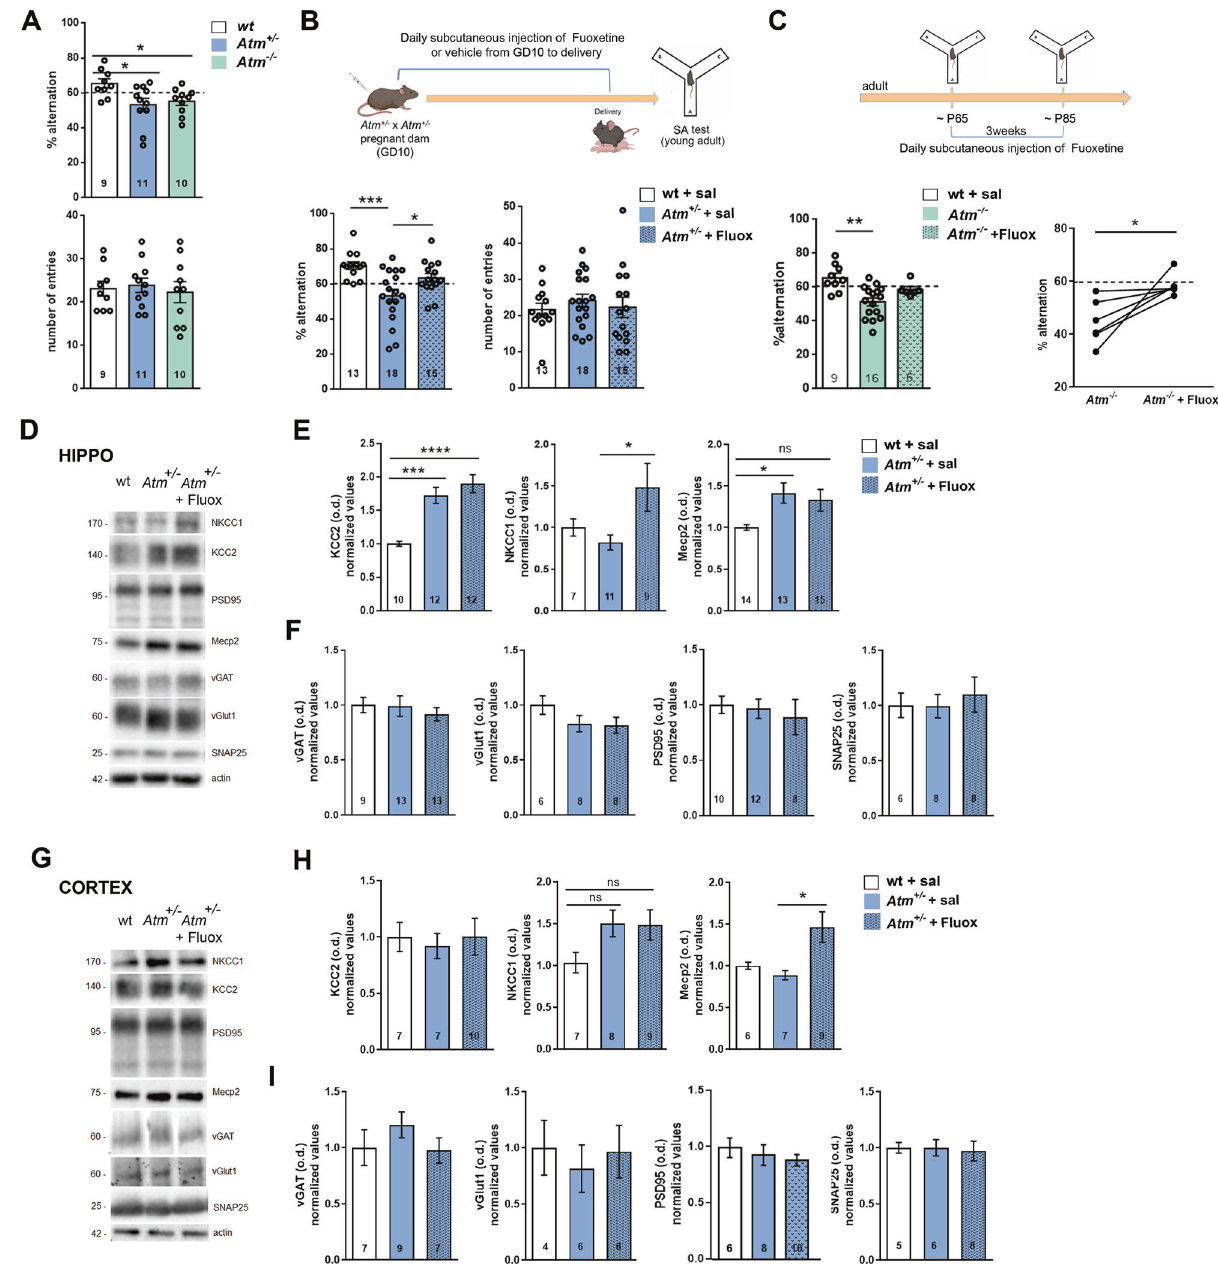
Fig. 1 Prenatal and postnatal fl uoxetine (Fluox) treatments revert cognitive disabilities in Atm + / − and Atm − / − mice. A Percentage of alternation (top) and number of entries (bottom) in the Spontaneous Alternation (SA) test in wt, Atm + / − and Atm − / − P40 mice. Ordinary one- way ANOVA followed by Dunnett ’ s multiple comparison test; * p < 0.05. B Prenatal Fluox treatment (top). We mated Atm + / − female with Atm + / − males and injected Fluox and starting from embryonic day 10 to delivery, we daily injected subcutaneously pregnant Atm + / − dams with Fluox (10 mg/kg). In this fi rst protocol, no Atm − / − mice were born, maybe due to the embryonic fragility linked to the complete ATM absence. Percentage of alternation and number of entries (bottom) in the SA test in wt + sal, Atm + / − + sal and in Atm + / − + Fluox. Ordinary one-way ANOVA followed by Tukey ’ s multiple comparison test; * p < 0.05, *** p < 0.001. C Fluoxetine treatment in adult mice (top). Atm − / − mice shows rescued % of alternation when chronically treated with Fluox for three weeks. Kruskal – Wallis test followed by Dunn ’ s multiple comparison test, ** p < 0.01, Wilcoxon paired test; p = 0.031. D Representative Western blot lanes for hippocampal samples. E Western blotting analysis shows increased KCC2 and Mecp2 expression in the hippocampus of Atm + / − mice but no rescue was observed in Atm + / − mice prenatally treated with Fluox; ordinary one-way ANOVA followed by Tuckey ’ s multiple comparison test; * p < 0.01, *** p < 0.001, **** p < 0.0001. Fluox treatment promotes NKCC1 expression speci fi cally; ordinary one-way ANOVA followed by Tuckey ’ s multiple comparison test; * p < 0.01. F No difference was observed in synaptic markers among wt and Atm + / − mice in the hippocampus, not even upon Fluox treatment. G Representative Western blot lanes for cortical samples. H KCC2, NKCC1, and MeCP2 protein levels are not affected in the cortex of Atm + / − mice, not even upon Fluox administration. I No difference was observed in synaptic markers among wt and Atm + / − in the cortex. Numbers in bars indicate the number of animals. ns means not signi fi cant . Bars in graphs indicate